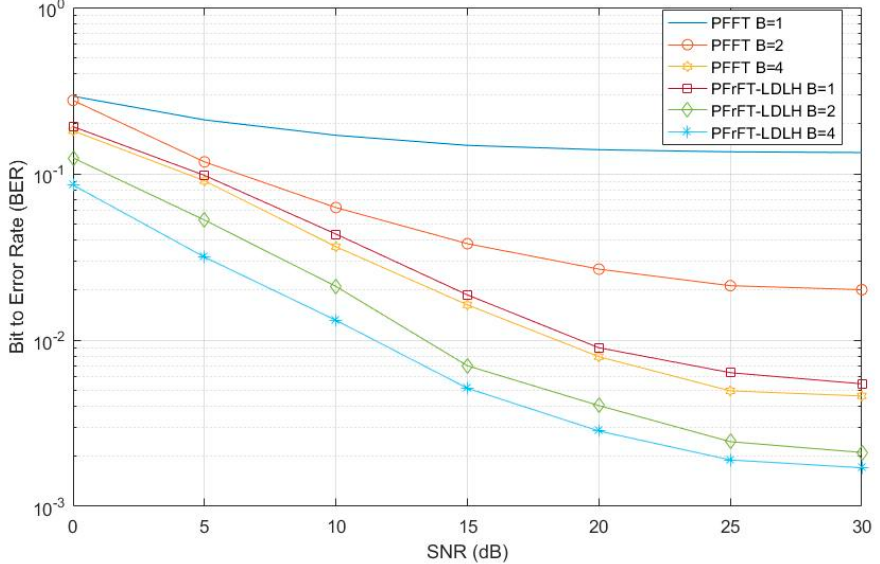
Figure 4. BER performance of proposed PFrFT-LDL H compared to PFFT in [1] for a SISO-OFDM scenario. The number of Monte Carlo runs is 10,000 for = B = 1, 2 and 4.